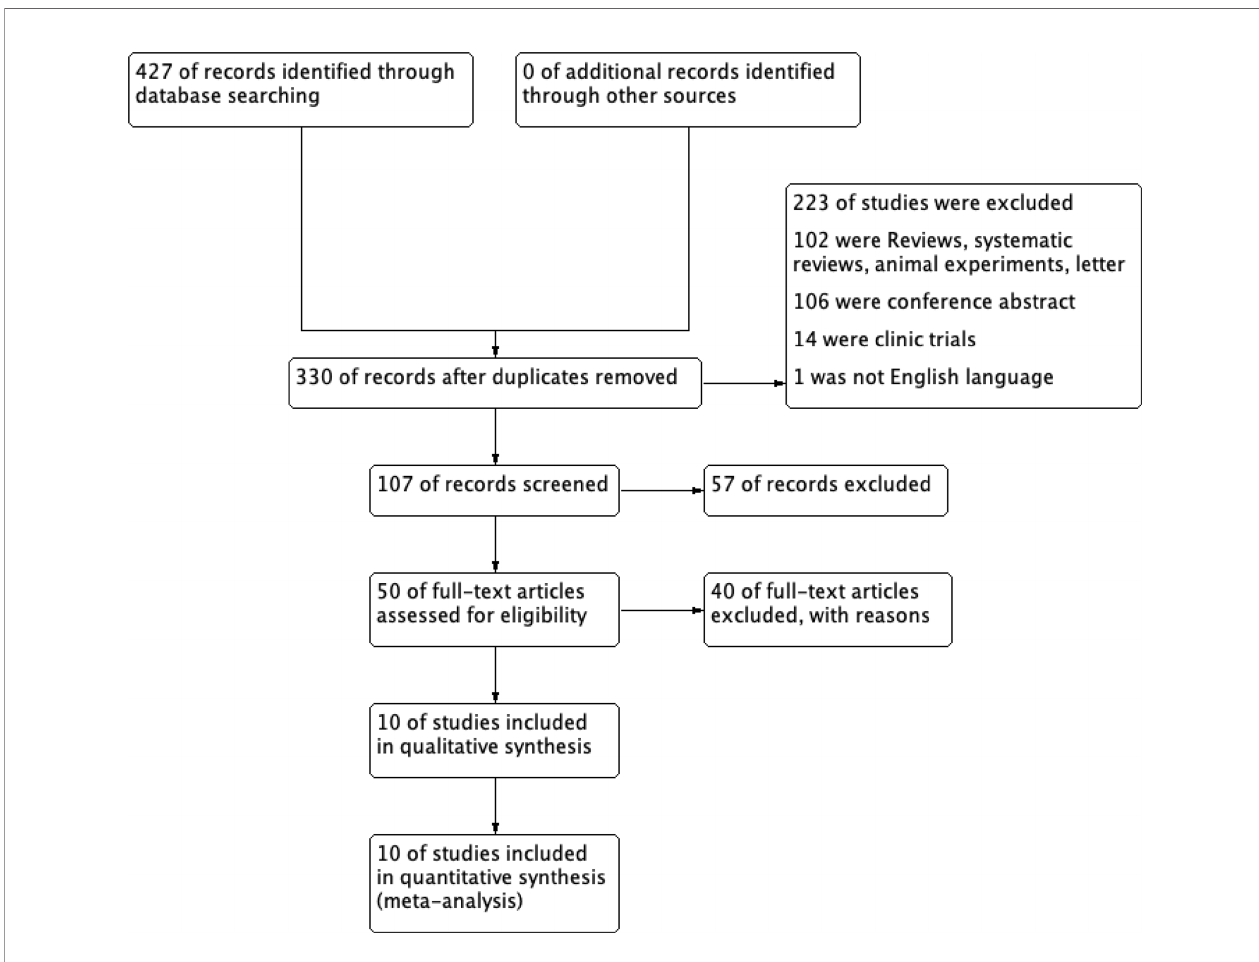
FIGURE 1 | Flow diagram of the study